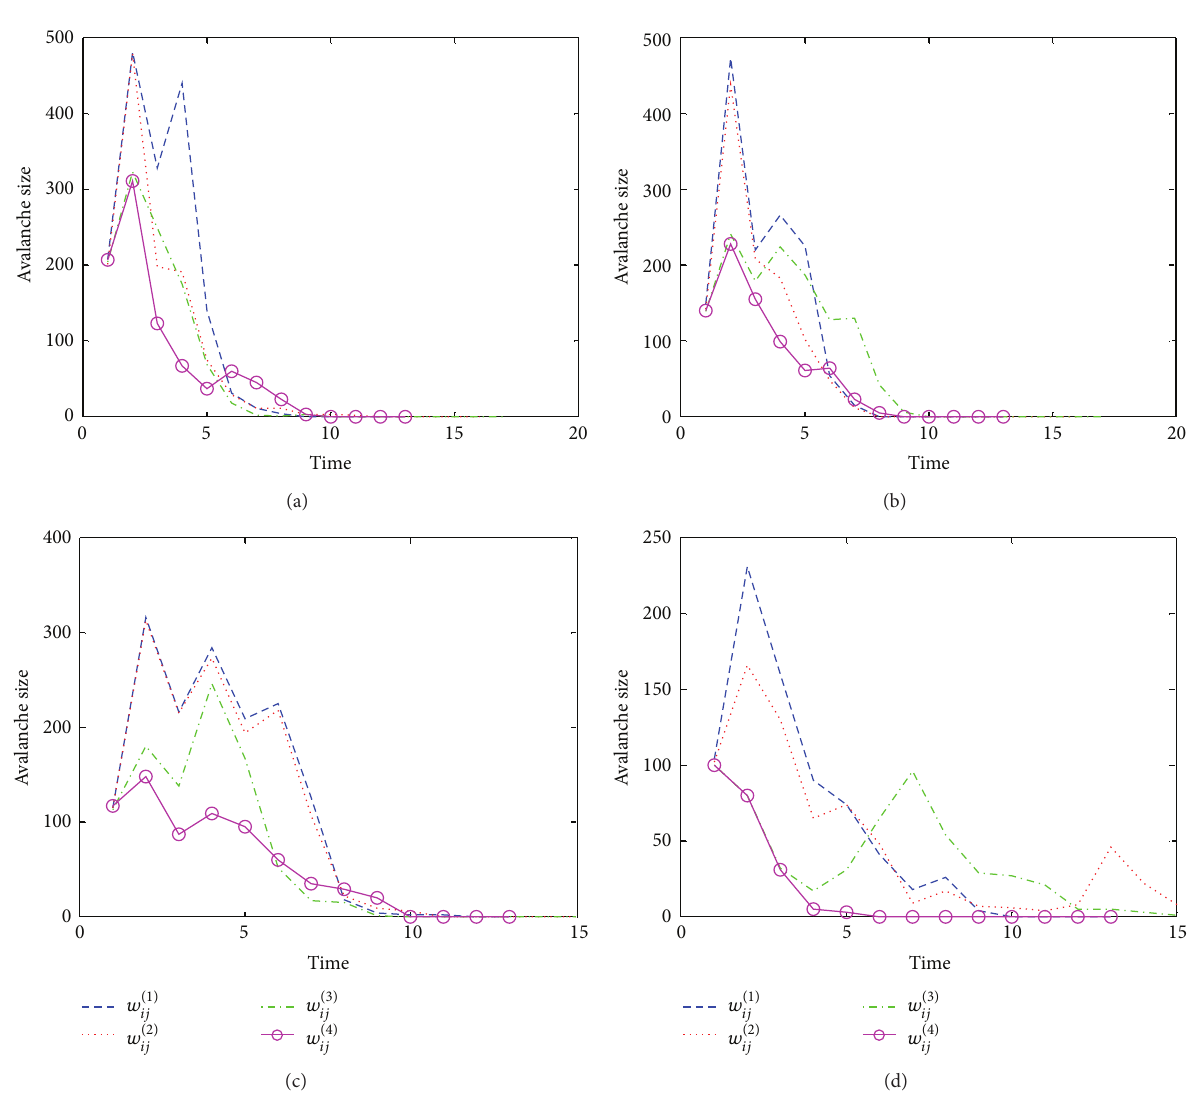
Figure 9: For autonomous system network with 𝜏 = 100 under HL attack, the avalanche size 𝑁 (a) 𝛼 = 0.02 , (b) 𝛼 = 0.04 , (c) 𝛼 = 0.06 , and (d) 𝛼 = 0.08 ,